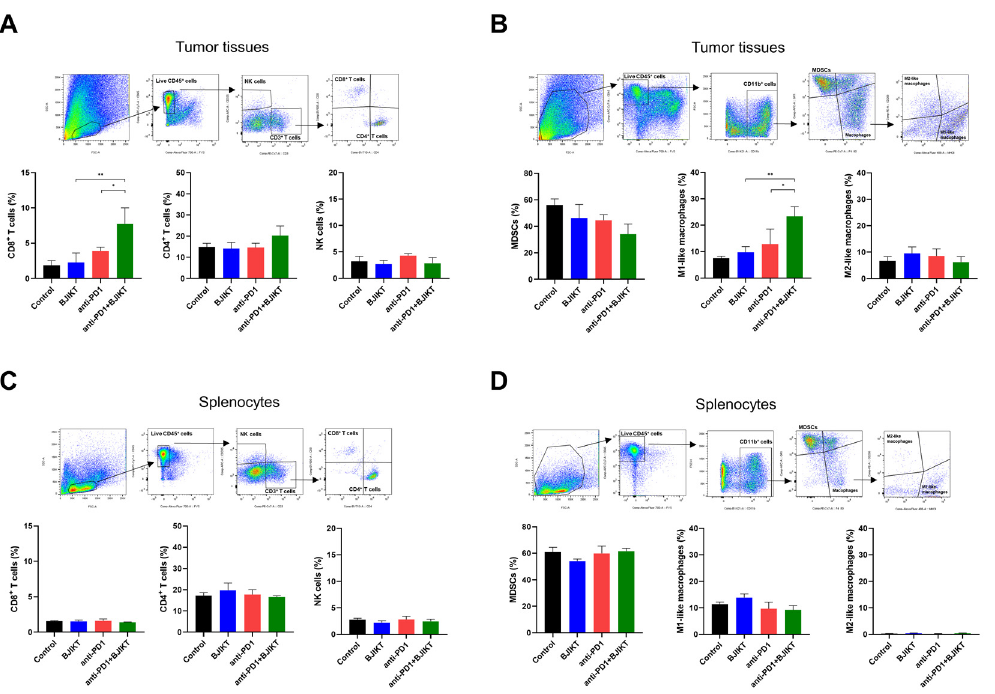
Figure 3. Flow cytometry analysis of immune markers on tumor tissues and splenocytes in KLN205 tumor-bearing mice. The cells from tumor tissues and the spleen were dissociated and gated based on CD45 + live cells. ( A ) Lymphocytes were stained with anti-CD45, anti-CD3, anti-CD4, anti-CD8, and anti-CD335 (NKp46) antibodies for tumor tissue analysis. ( B ) Myeloid cells were stained with anti-CD45, anti-CD11b, anti-F4/80, anti-GR-1, anti-MHC Class II, and anti-CD206 antibodies for tumor tissue analysis. ( C ) Lymphocytes were stained with anti-CD45, anti-CD3, anti-CD4, anti-CD8, and anti-CD335 antibodies for splenocytes analysis. ( D ) Myeloid cells were stained with anti-CD45, anti-CD11b, anti-F4/80, anti-GR-1, anti-MHC Class II, and anti-CD206 antibodies for splenocyte analysis. * p < 0.05 and ** p < 0.01, compared to the combination group.